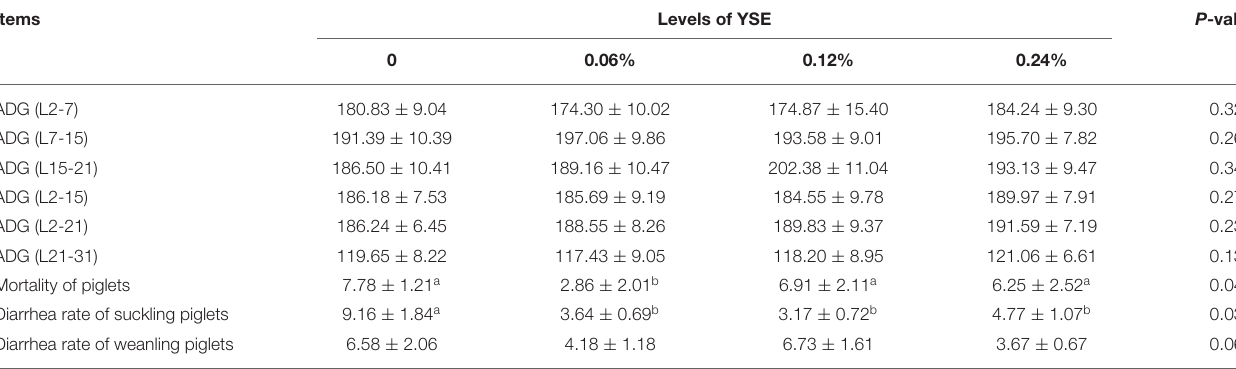
TABLE 3 | Effect of dietary YSE to piglet